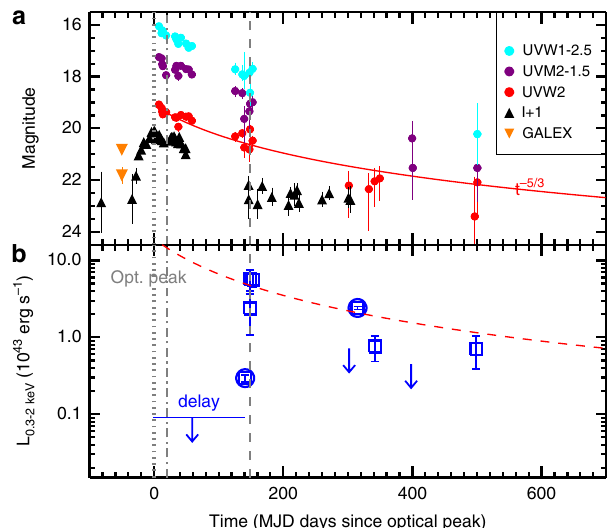
Fig. 1 UV-optical and X-ray light curve of OGLE16aaa. a The host- subtracted, Galactic dust extinction-corrected UV and optical light curve. The Swift UVW1, UVM2, and UVW2 photometric data are shown in cyan, dark purple, and red, respectively. We also plot the pre- fl are GALEX UV data for comparison (orange). The optical I -band data are shown in black triangles. The light curves are shifted by constants for clarity as noted in the legend. All magnitudes are in the AB system. Error bars represent 1 σ uncertainties due to photometric errors. The red line represents the fi t to the UVW2 data with a canonical n = − 5/3 power-law decay, assuming the same peak time as optical one 21 that is marked with gray dotted line. The dot-dashed line represents the approximate time of optical rebrightening, t ≈ 20 days with respect to the initial peak. The dashed line marks the time for the X-ray peak. It is noteworthy that the true peak time might be slightly later, as no further observations are performed between the current peak and the non-detection at t = 302 days. b The follow-up X-ray observations from Swift (square) and XMM-Newton (circle). The 3 σ upper limits on the fl ux for non-detections (see Table 1 and text) are shown with downward pointing arrows. The X-ray emission shows a clear time delay with respect to optical by ~140 days and brightened to peak within only ~2 weeks. All the X-ray luminosities are corrected for the absorption. Error bars represent 1 σ uncertainties calculated using Monte Carlo simulations provided in XSPEC. The red dashed line corresponds to the best- fi t to UVW2 data in the upper panel, but scaled to the UV/optical blackbody luminosity at t = 153 days (Supplementary Fig.